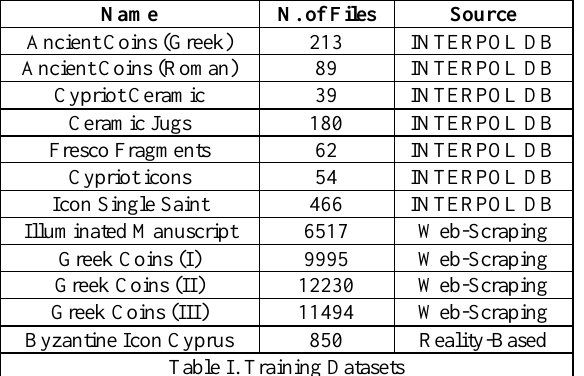
Table I. Training Datasets